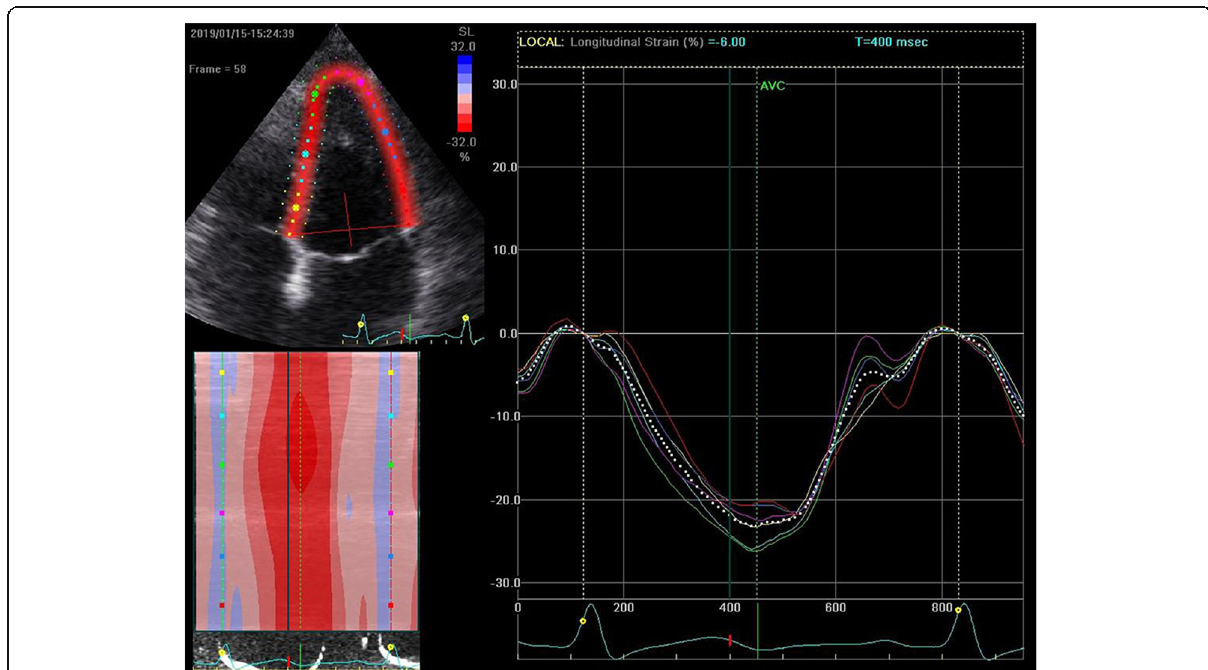
Fig. 1 Measurement of GLS of a healthy individual by 2D-STE. The image was obtained from the apical four-chamber view